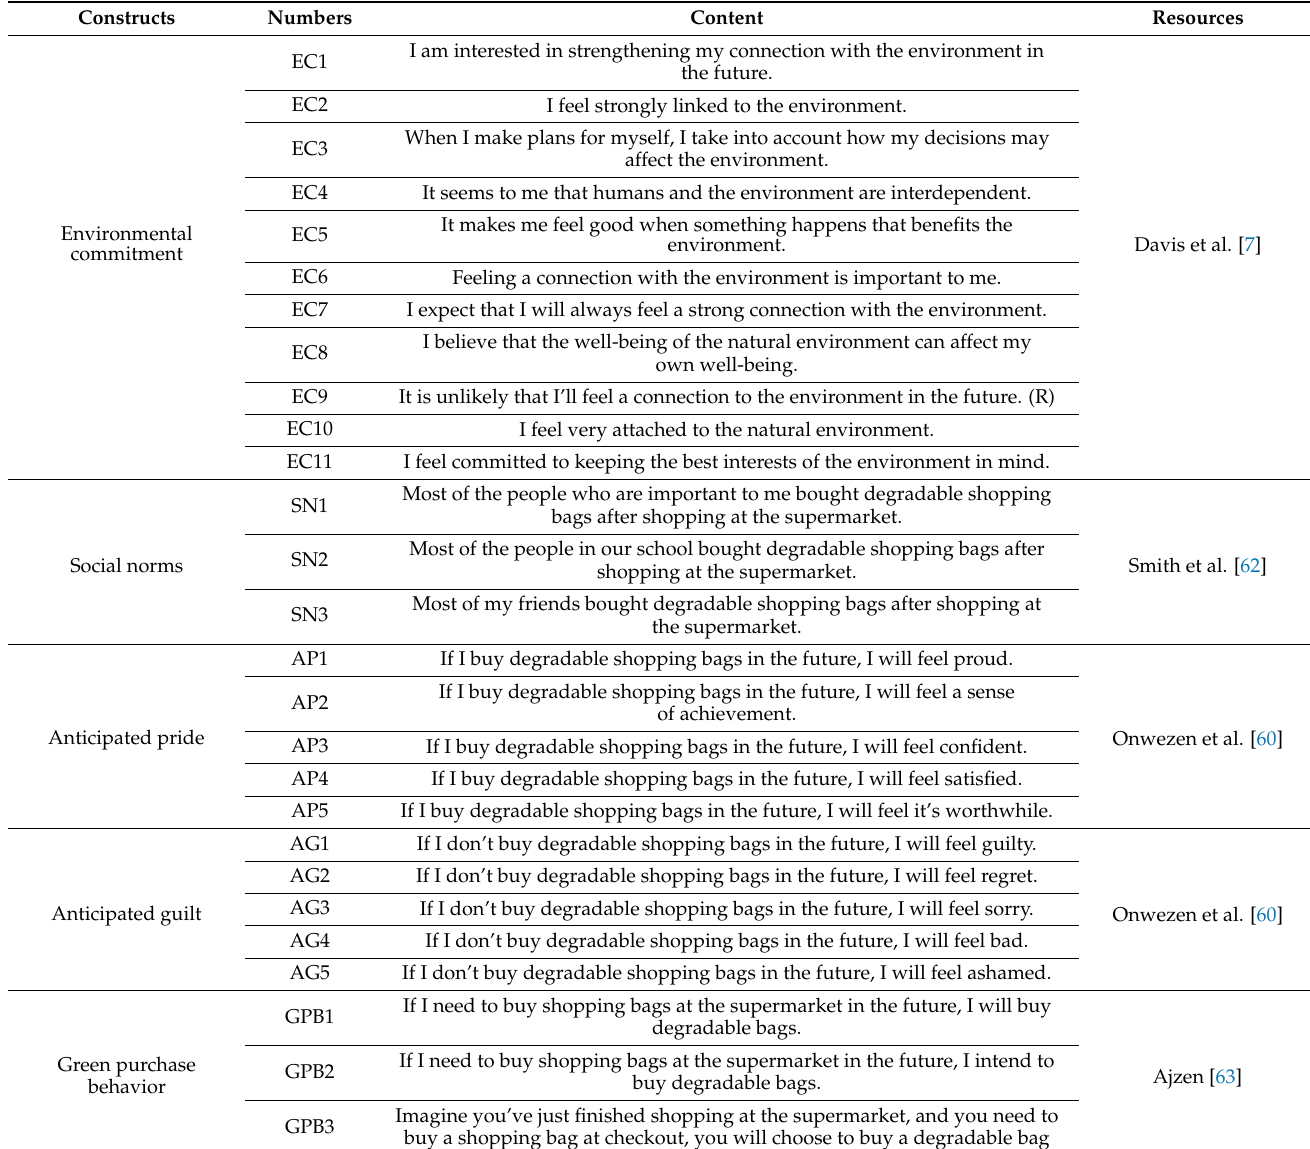
Table A1. The information of the